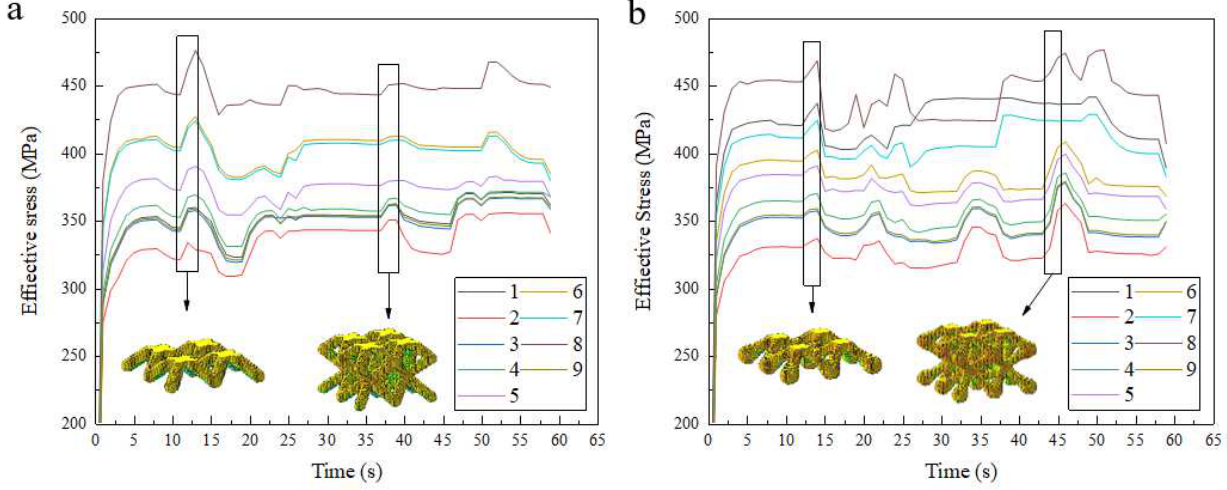
Figure 8. Construction stress variation diagram: ( a ) conventional BCC Structure and ( b ) optimized BCC Structure.